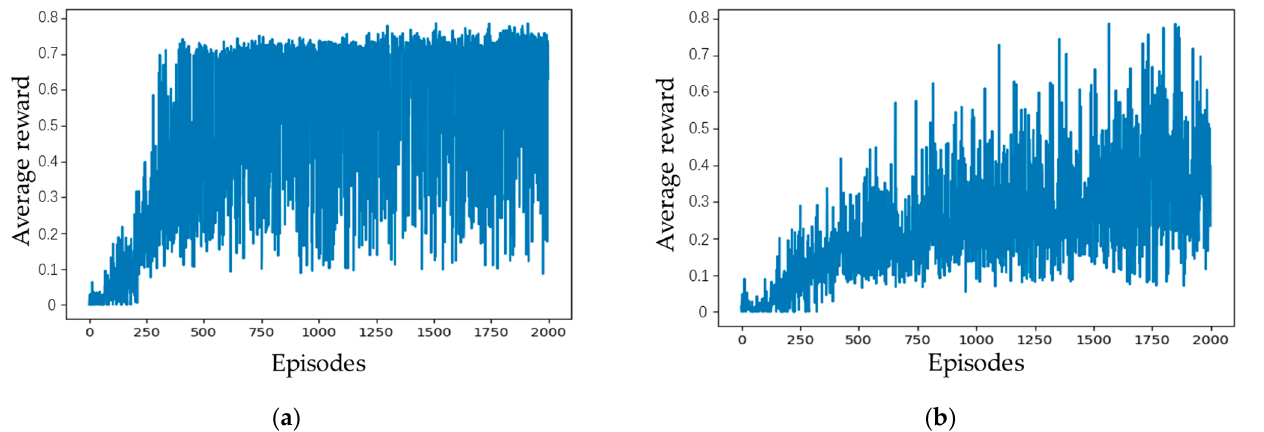
Figure 18. Training results of algorithms using di ff erent network structures: ( a ) using the a tt ention network and ( b ) not using the a tt ention network.